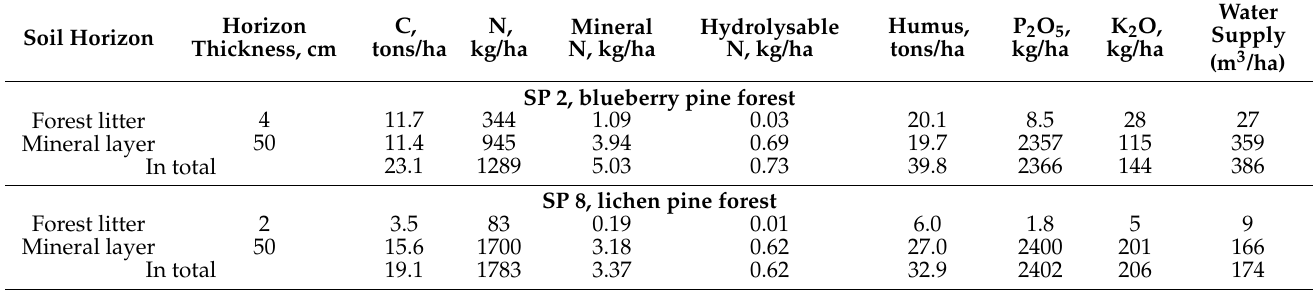
Table 3. C, N, P, K reserves and water supply in the 50 cm soil layer of the studied pine forests. Horizon Soil Horizon Thickness, cm